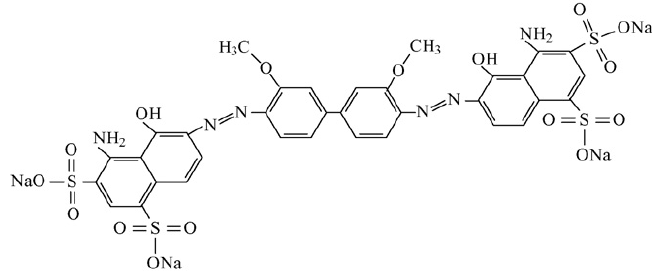
Figure 1. Direct Blue 1 (DB1) structure [8].